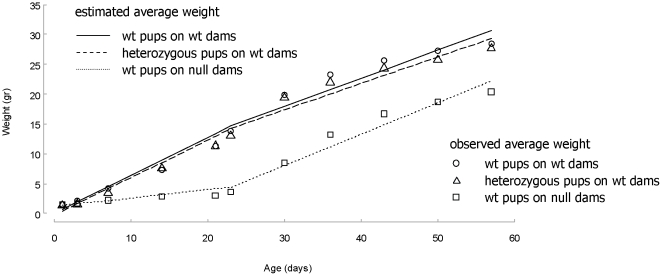
Model estimates for weight increase across experimental groups.Average growth rates were determined for wild-type pups nursed by wild-type dams (group 1), wild-type pups nursed by α-casein deficient dams (group 2) and heterozygous pups nursed by wild-type dams (group 3). The estimated increases were compared to the observed values over the first 60 days of life.